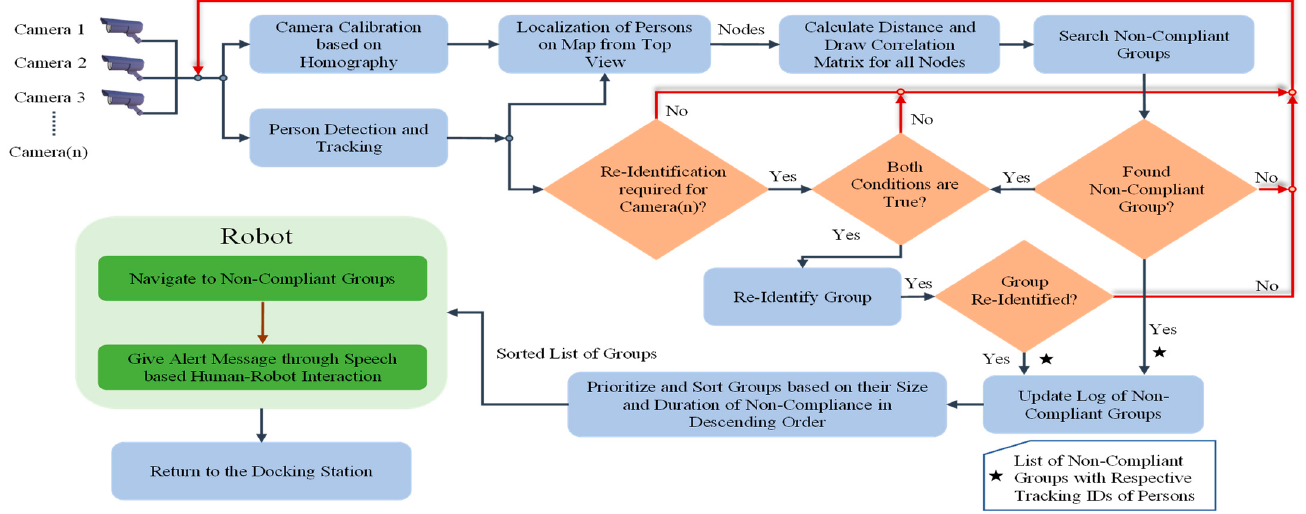
Figure 3. Overall system architecture.